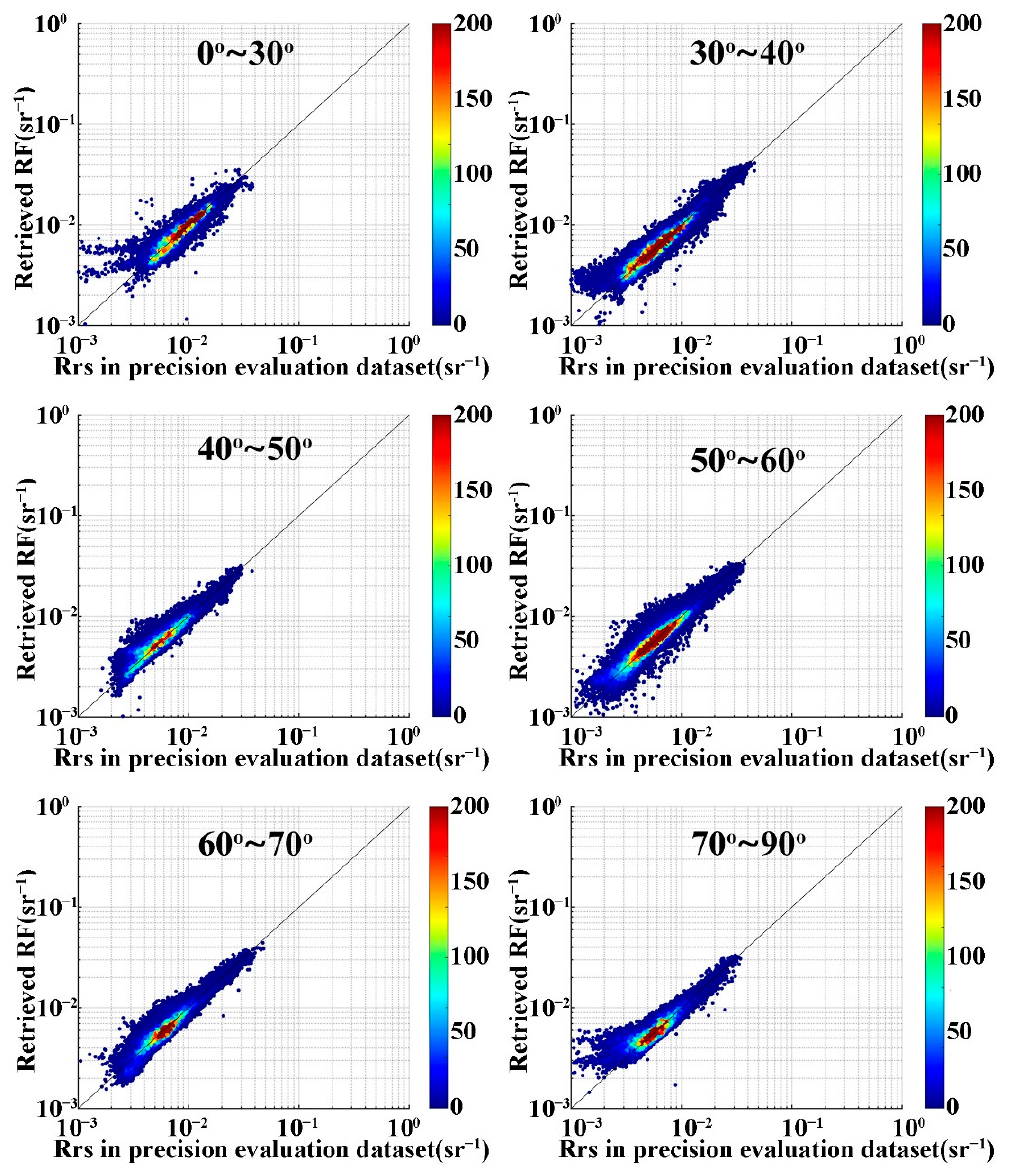
Figure 4. Inversion results of the neural network atmospheric correction algorithm in different SZAs. The color bar represents the number of points. Table 2. The statistical parameters obtained by the algorithm are verified using precision evaluation datasets for different SZAs.